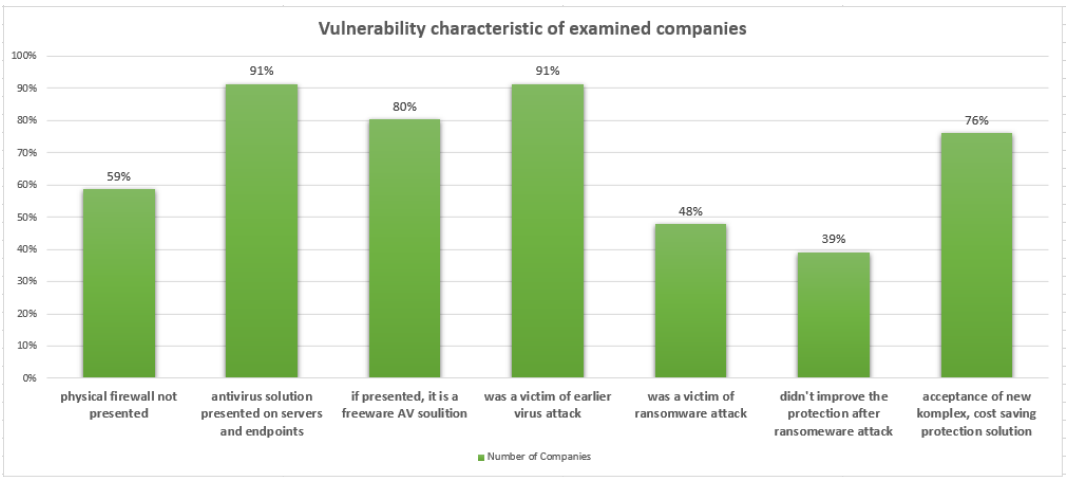
Figure 7. Vulnerability characteristics of examined companies.